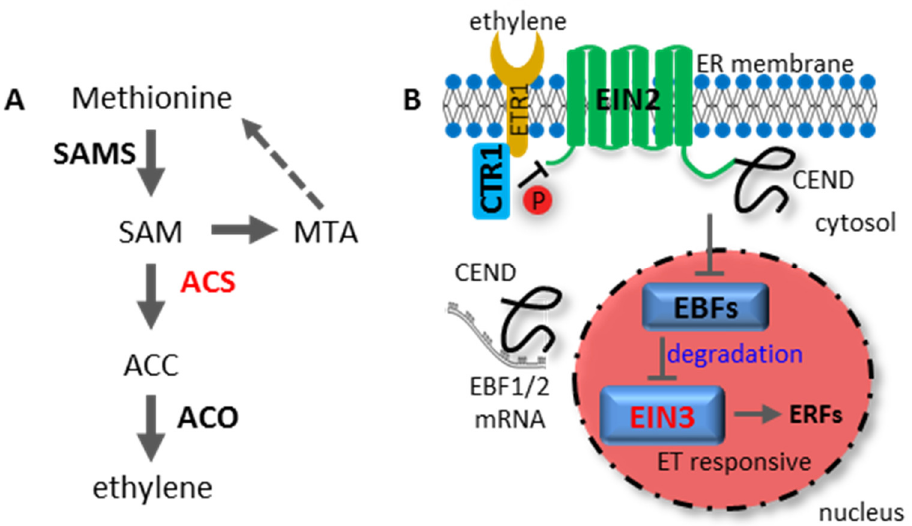
Figure 2. Ethylene (ET) biosynthesis and the signaling cascade pathway. ( A ) Model for the ET biosynthesis pathway. The precursor SAM is produced by SAMS with methionine as substrate. SAM is converted to the intermediate chemical ACC by ACS with the release of MTA as byproduct. MTA is recycled to methionine through the so-called Yang cycle. The rate-limiting enzyme ACS is highlighted in red. ( B ) Model for the ET signaling cascade. In the absence of ET, CTR1 phosphorylates EIN2 and the ET pathway is therefore blocked. In the presence of ET and when it is perceived by ET receptor (i.e., ETR1, ETHYLENE RESISTANT 1), the kinase activity of CTR1 is inactivated, the EIN2 CEND becomes dephosphorylated and cleaved. CEND subsequently translocates into the nucleus to attenuate EBFs E3 ligase function. In addition, CEND may bind to the UTR of EBF1/2 mRNA to perturb EBF1/2 translation in cytosol. Stabilized EIN3 protein then activates ERF transcription factors (i.e., ERF1 and ORA59) to elicit the ET response. Abbreviations: ACC, 1-Aminocyclopropane-1-carboxylic acid; ACO, ACC-oxidase; ACS, ACC synthase; CEND, C-terminal end of EIN2; CTR1, constitutive triple response 1; EBF1/2, EIN3-binding F-Box 1/2; EIN, ethylene insensitive; ER, endoplasmic reticulum; ERF, ethylene-response factor; ET, ethylene; ETR1: ethylene-resistant 1; MTA, methylthioadenosine; SAM, S-adenosyl methionine; SAMS, SAM